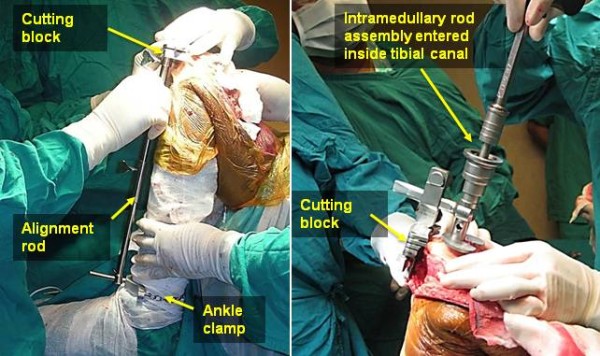
Extramedullary guide (left) andintramedullary guide (right).